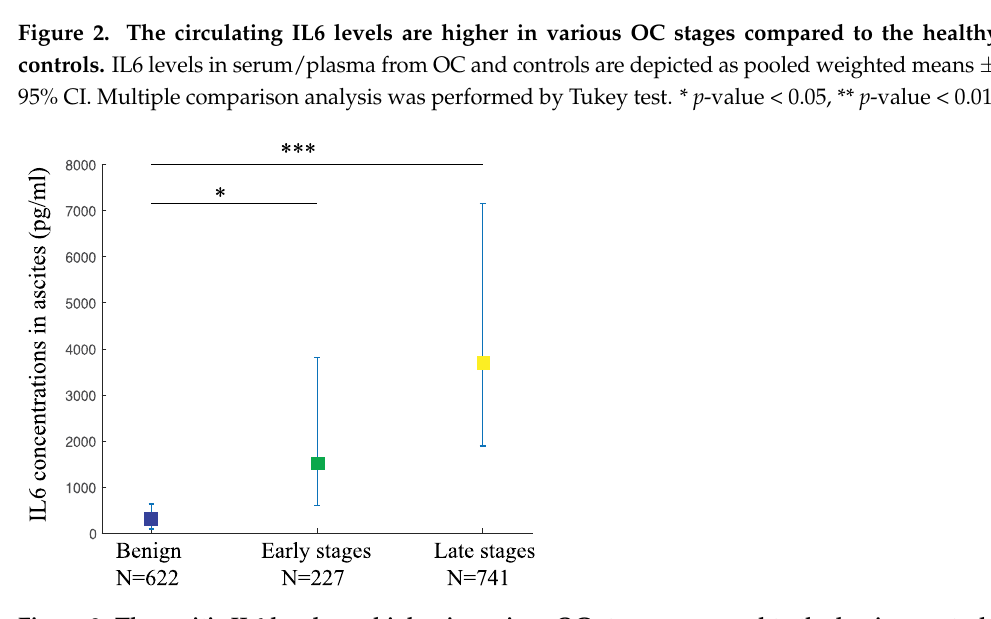
Figure 3. The ascitic IL6 levels are higher in various OC stages compared to the benign controls. IL6 levels in ascites from OC and controls are depicted as pooled weighted means ± 95% CI. Multiple comparison analysis was performed by Tukey test. * p -value < 0.05, *** p -value < 0.001. Table 2. The pooled weighted means of IL6 levels in ascites with 95% CI.